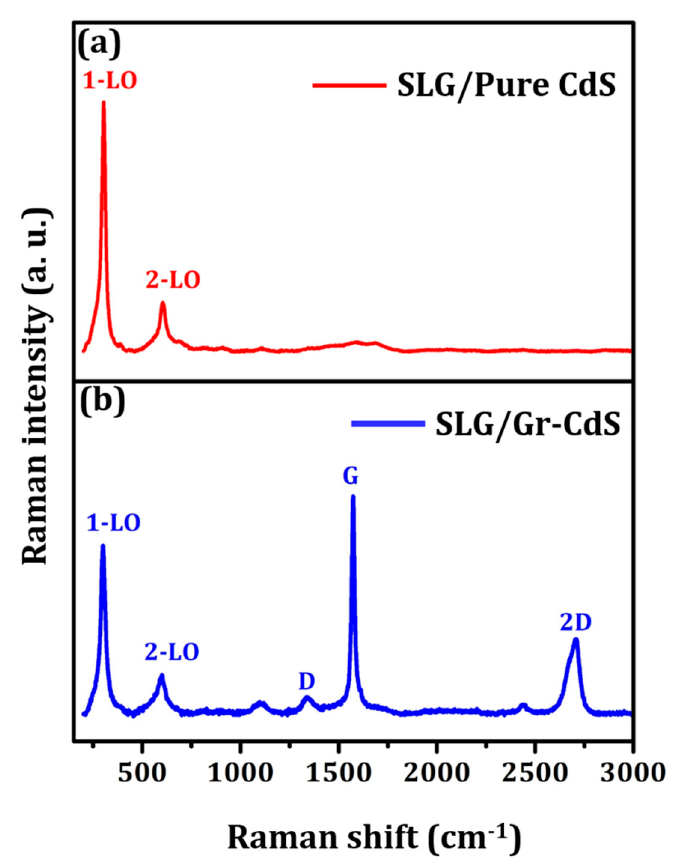
Figure 5. Raman spectra of ( a ) pure CdS NPs and ( b ) Gr–CdS nanocomposite.